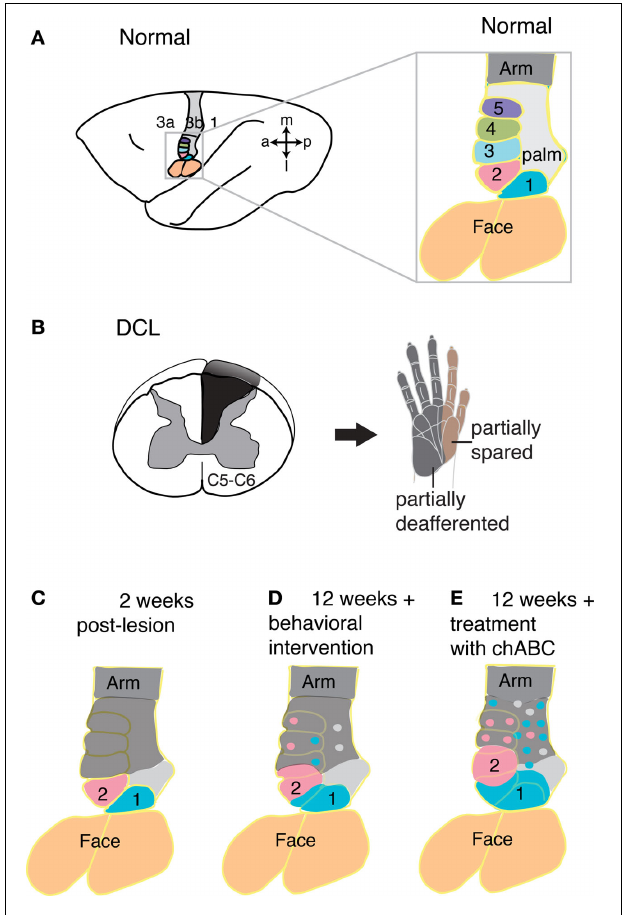
FIGURE 6 | Spontaneous and augmented recoveries from sensory loss in monkey cortex. (A) Schematic view of the left hemisphere of an owl monkey brain with area 3b highlighted in color and expanded (right) to focus on the hand representation. (B) When afferents devoted to the hand are cut in the cervical spinal cord at the C5 or C6 level in squirrel monkeys and owl monkeys (left), inputs from much of digit 1 and digit 2 are spared, while inputs from most of the rest of the hand are disrupted, as indicated by the hand schematic (right). (C) After such a lesion (B) , the hand representation in primary somatosensory cortex is immediately rendered largely unresponsive to tactile stimuli (gray shading), with the exception of much of the digit 1 and digit 2 representations (blue and pink shading, respectively), for which the majority of axons enter the spinal cord above the level of the lesion. Over weeks of spontaneous post-lesion recovery without augmentation, the deactivated cortex becomes partly reactivated by inputs from the hand with activation from the spared dorsal column inputs (digits 1 and 2), and possibly other pathways (not shown). (D) This schematic summarizes expected results in monkeys with dorsal column lesions that received behavioral intervention when the cortex is studied 12 weeks after the lesion. Sensorimotor training and testing for use of the impaired hand appears to promote reactivation of cortex, but further study is needed to determine how effective behavioral intervention is beyond spontaneous recoveries and in comparison with other types of treatments. Based on previous findings and ongoing research, we expect that the representations of spared digits will expand their territories and islands of responsiveness will emerge in previously unresponsive zones. (E) The effectiveness of a few preserved dorsal column afferents for activating cortex can be enhanced by treatment of the target site in the cuneate nucleus with the enzyme chondroitinase ABC shortly after the spinal cord injury. Digestion